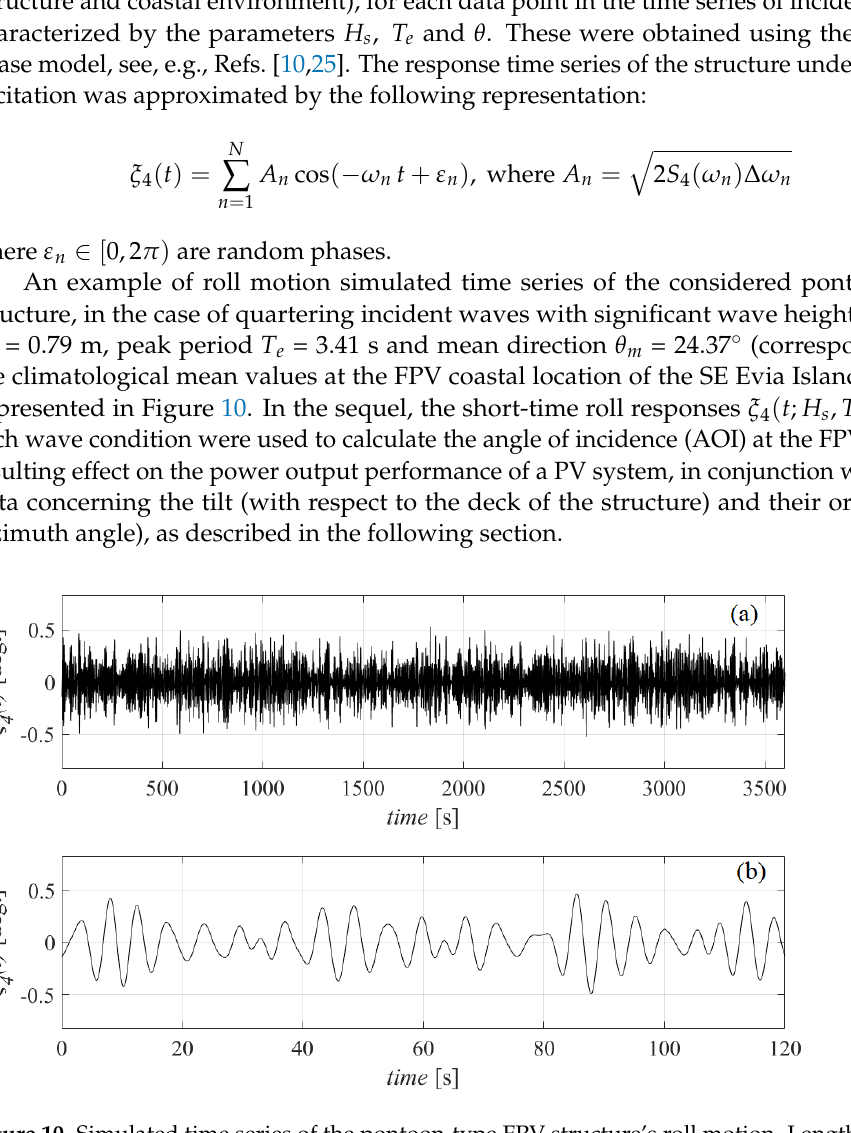
Figure 10. Simulated time series of the pontoon-type FPV structure’s roll motion. Length L = 45 m, breadth B = 15 m, draft 3 m, depth h = 15 m. Incident waves of significant wave height equal to H s = 0.79 m and energy period T e = 3.41 s . ( a ) Simulated 1 h-long time series data and ( b ) indicative roll motion in a 2 min long time interval.